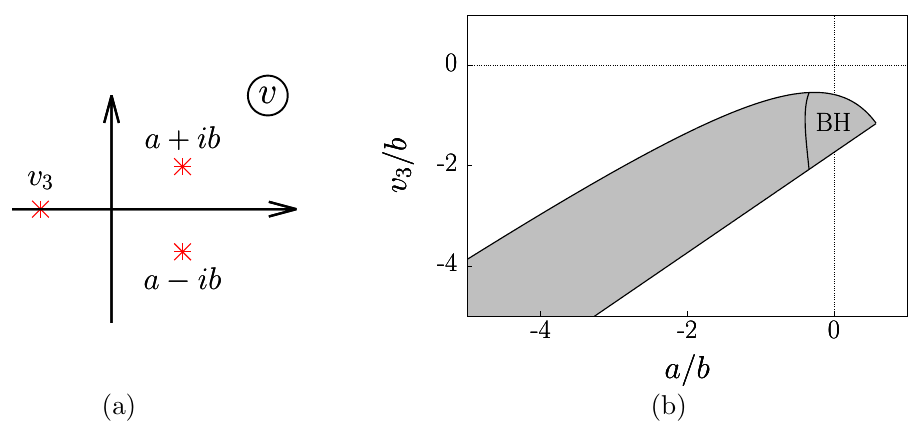
Figure 8 . (a) Singularities of the solution (3.24). (b) Parameters of this solution giving positive- de(cid:12)nite T vv ( v ) at v (cid:21) 0 (gray region). The upper right corner of this region corresponds to black hole